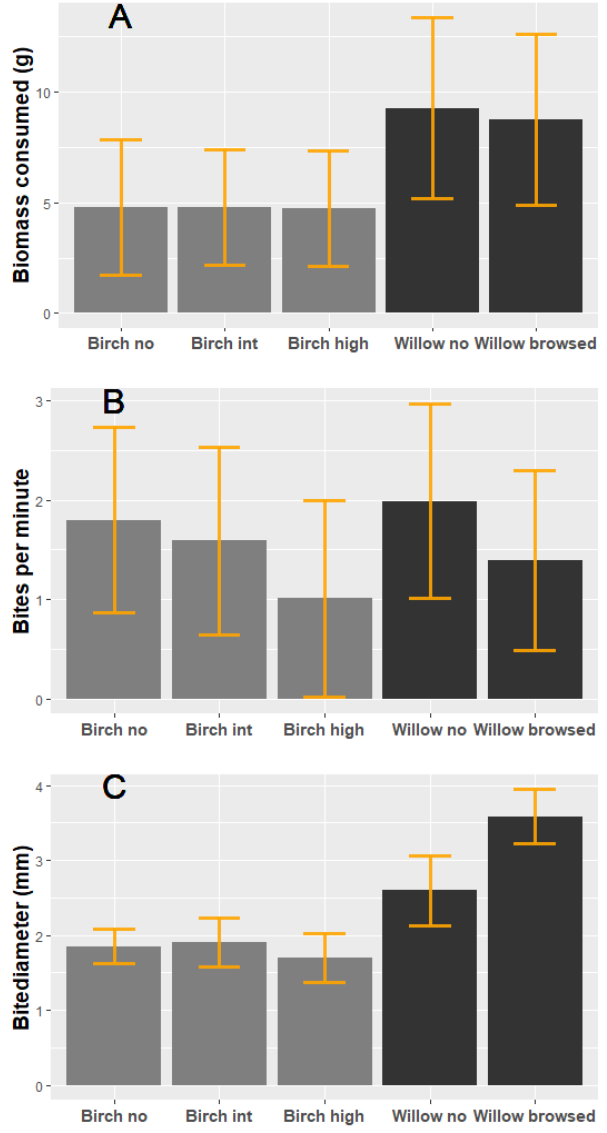
Figure 1. ( A ) consumption, ( B ) bites per minute and ( C ) bitediameter of downy birch (light bars) and goat willow (dark bars) ±95% CI in relation to previous moose browsing. Birch no (0%